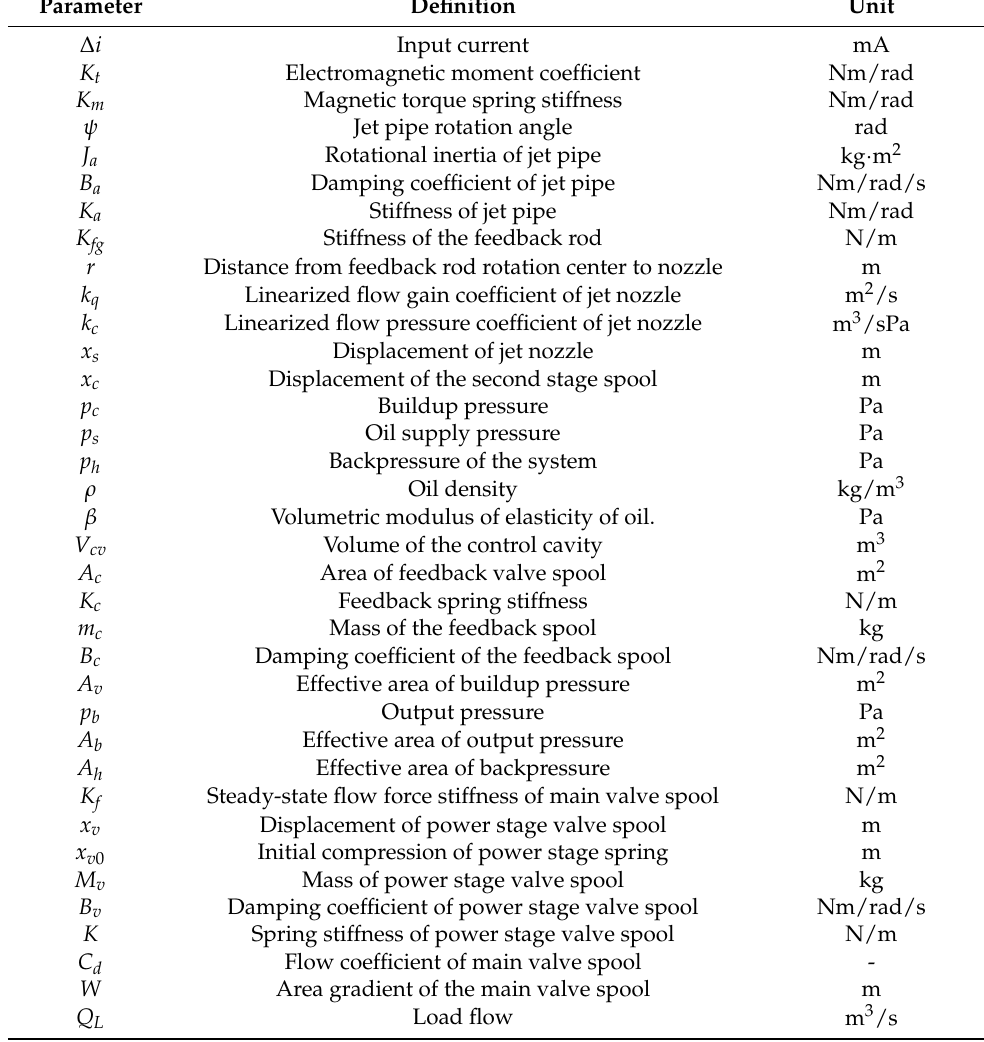
Figure 2. The structural schematic diagram of the pressure servo valve. Table 1. The parameters.